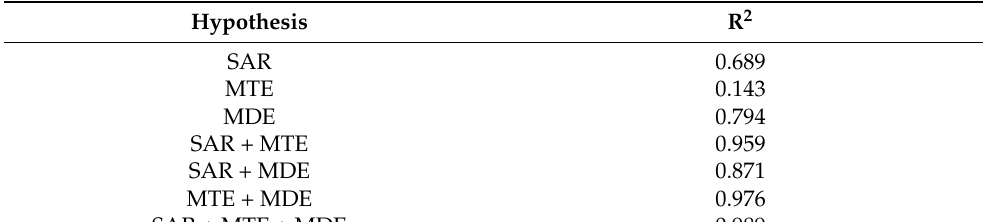
Table 1. Interpretation of the three hypotheses on the species diversity of seed plants in Qinling Mountains (R 2 ).